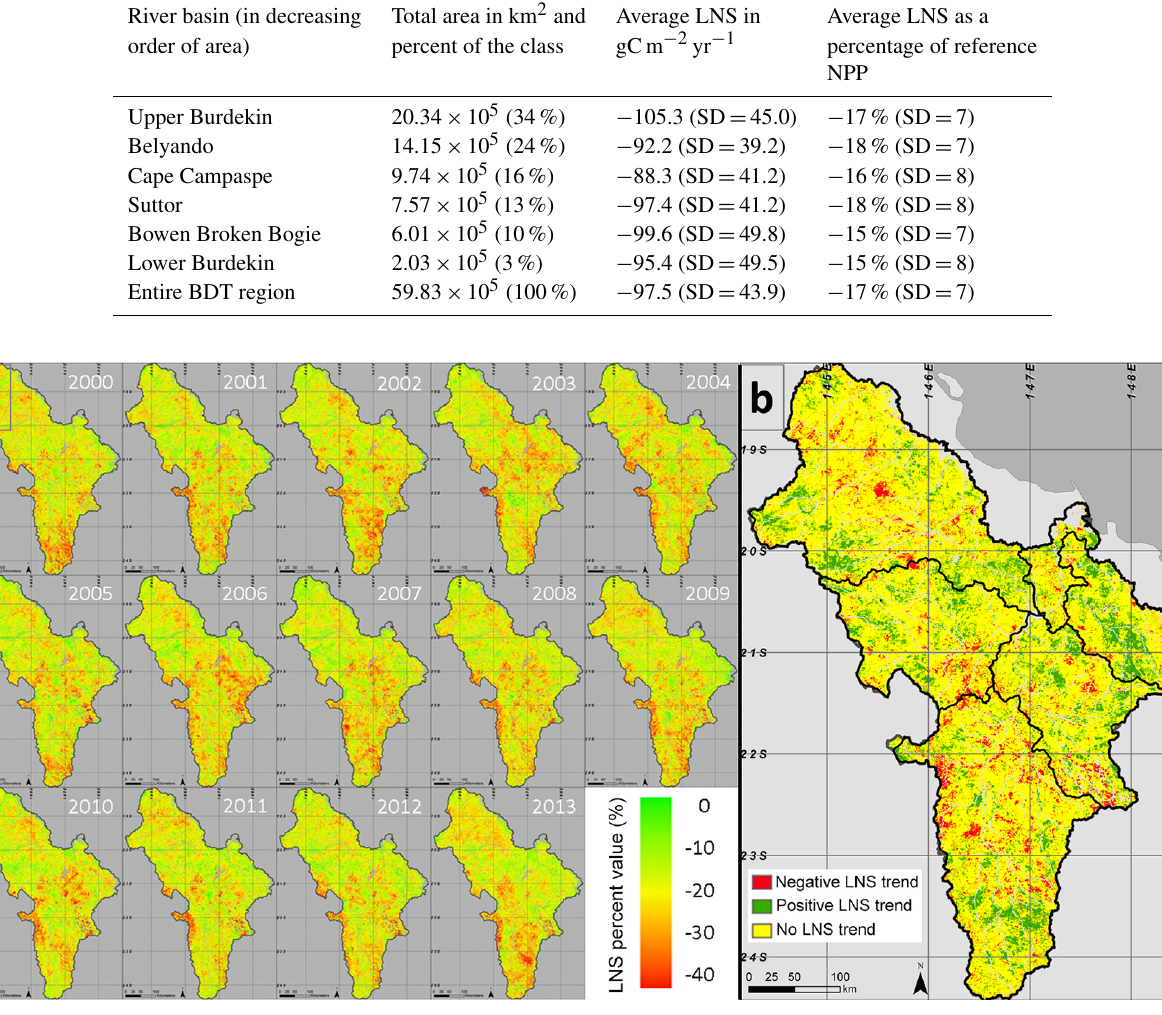
Figure 6. Time series of maps of the Burdekin Dry Tropics from 2000 to 2013 showing (a) annual LNS percent values from 2000 to 2013 and (b) interannual trends in LNS classified into negative, positive, and no LNS